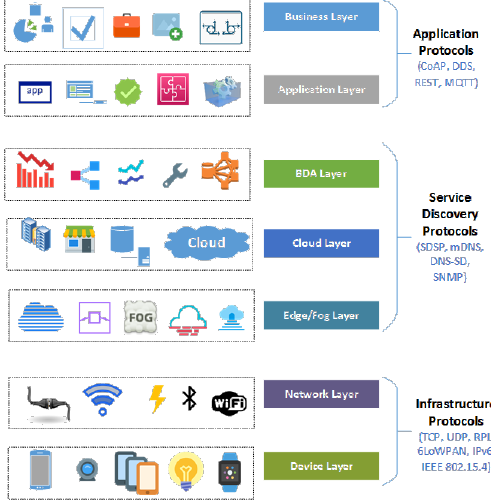
Figure 13. Protocol categorization of IWF